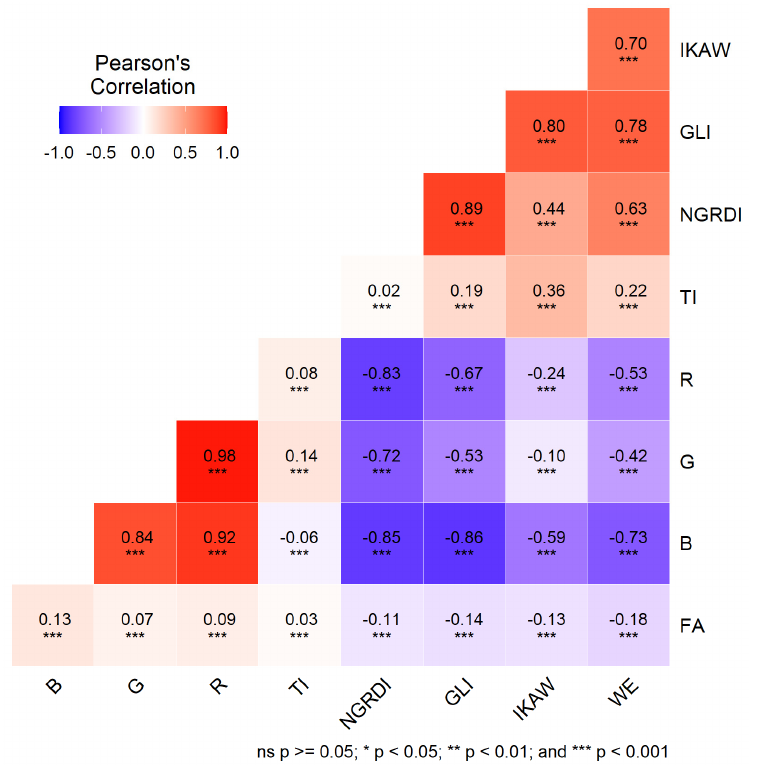
Figure 5. Correlation matrix based on Pearson’s correlation coefficients (TI: total insolation, FA: flow accumulation, WE: wind exposition).